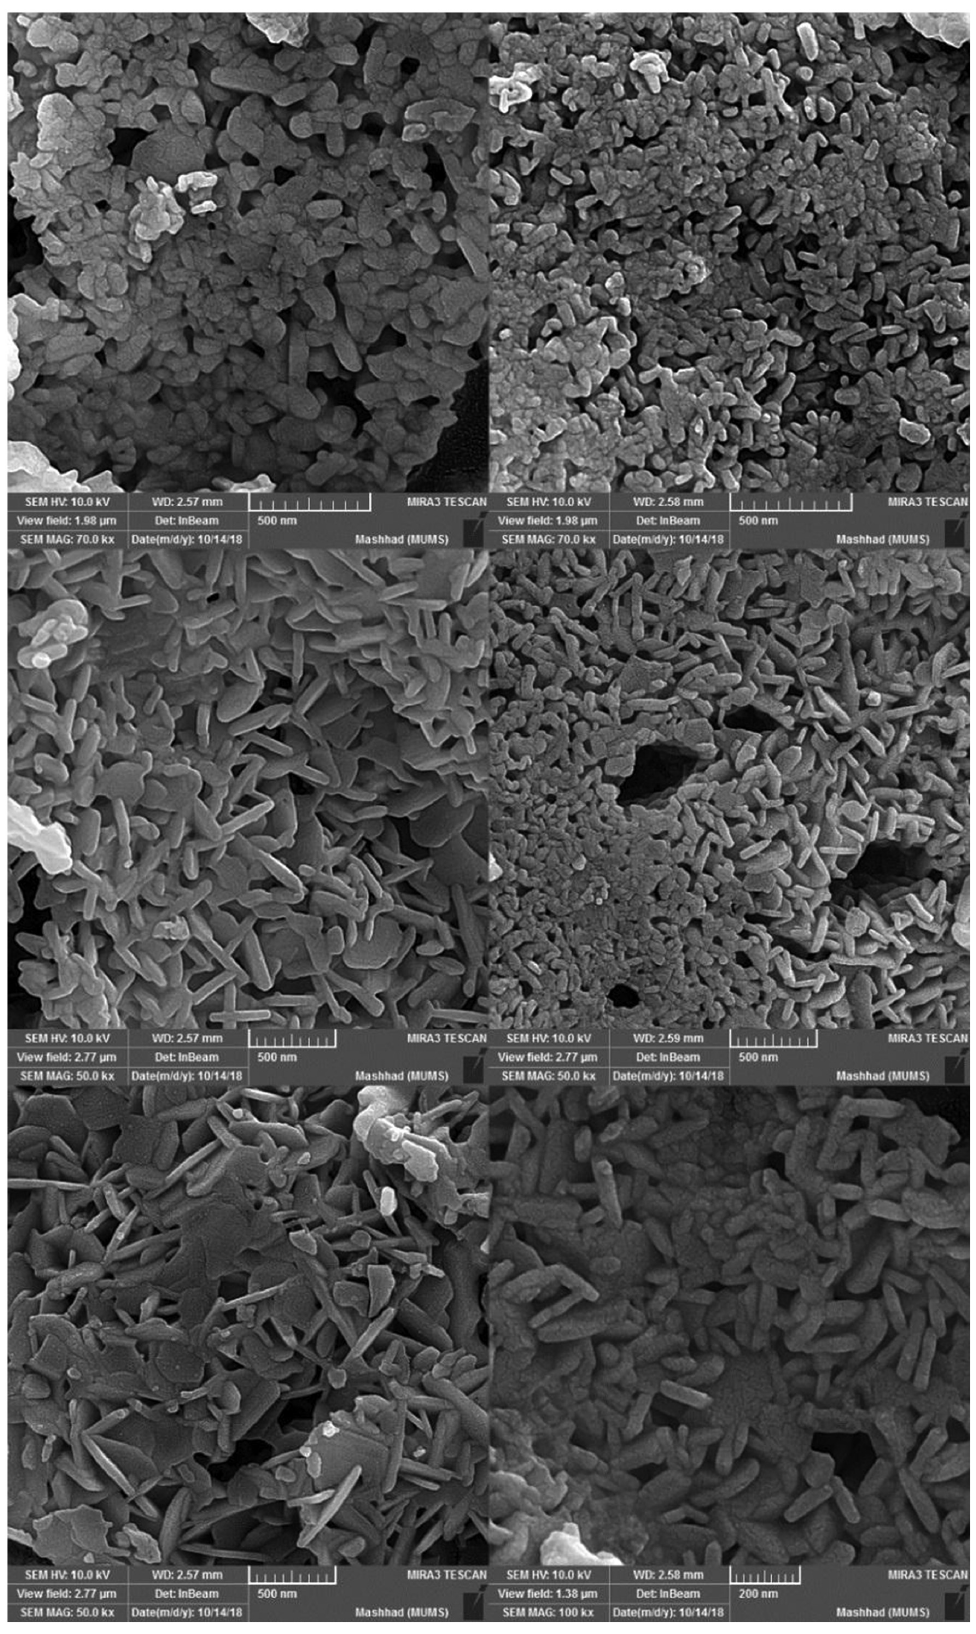
Figure 12: SEM images of nanocomposite SrFe